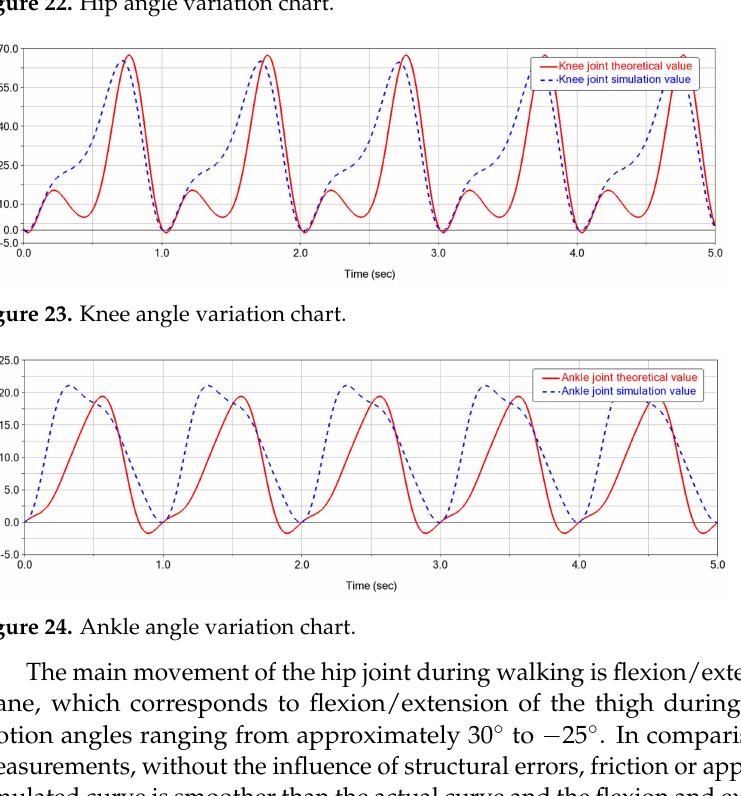
Figure 22. Hip angle variation chart.